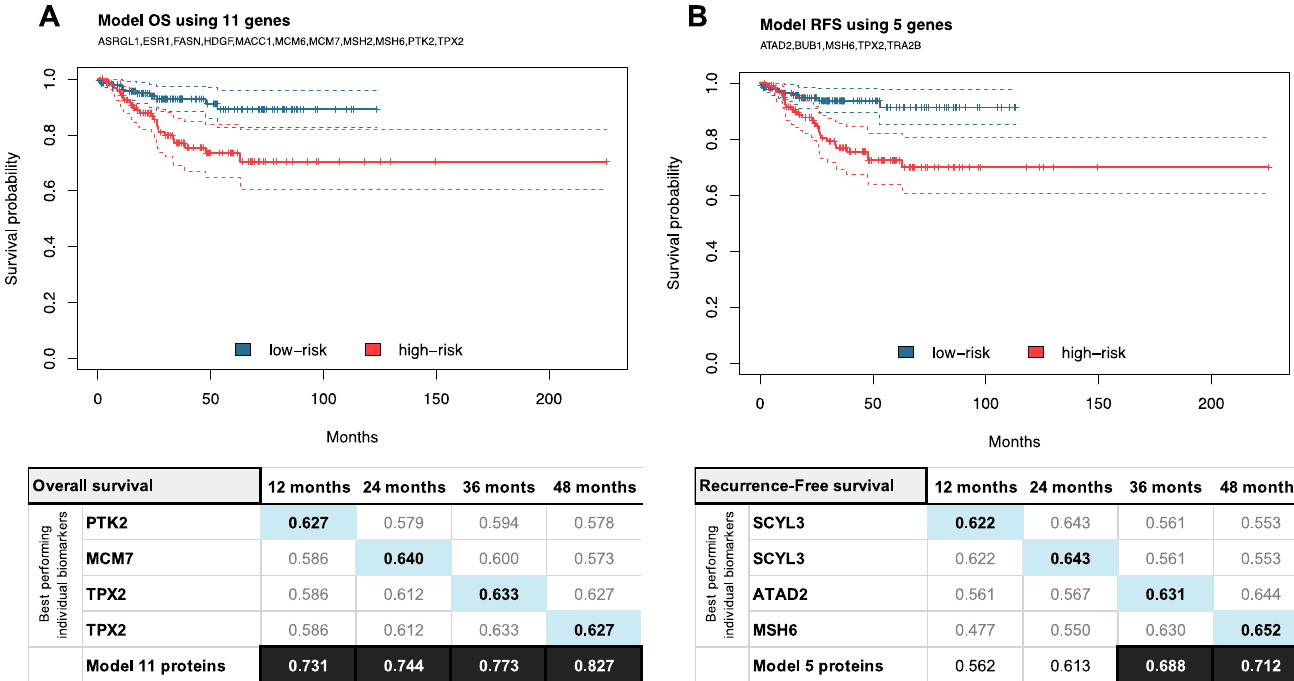
Figure 5. Biomarkers related to overall survival and recurrence free survival and model performance. Best performing individual biomarkers are shown for ( A ) overall survival (OS) and ( B ) recurrence free survival (RFS) for a period of 12, 24, 36, and 48 months, respectively. Additionally, models for both were performed. Regarding prediction of OS, a model of 11 proteins was used, ( A ) while a model of 5 proteins was used to predict RFS ( B ).